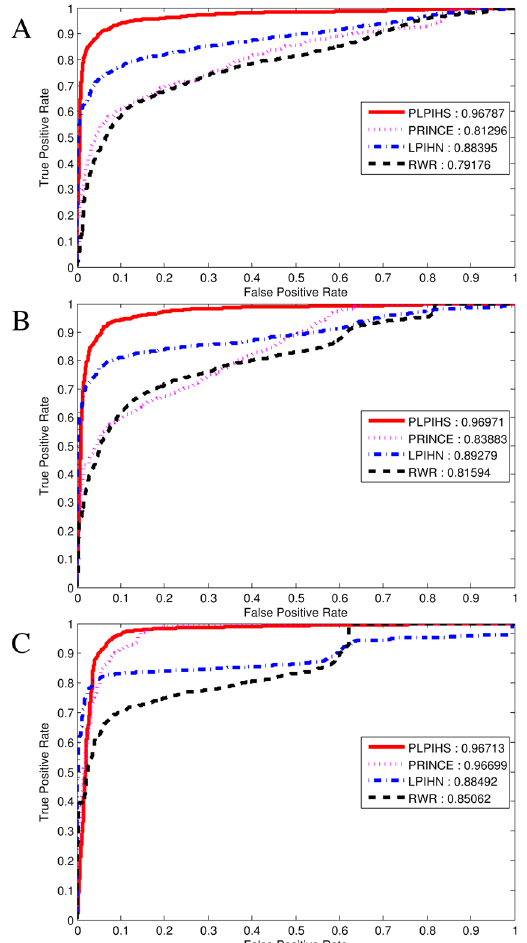
Figure 5. The ROC curves of all methods under 0.3 network, 0.5 network and 0.9 network.